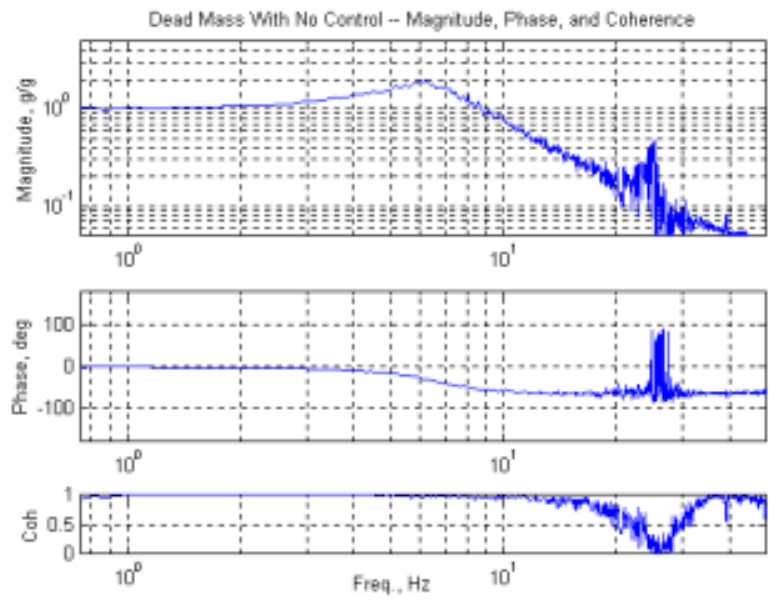
Fig. 12. Frequency response between the floor vibration and the mass motion: magnitude (top), phase (middle), and coherence